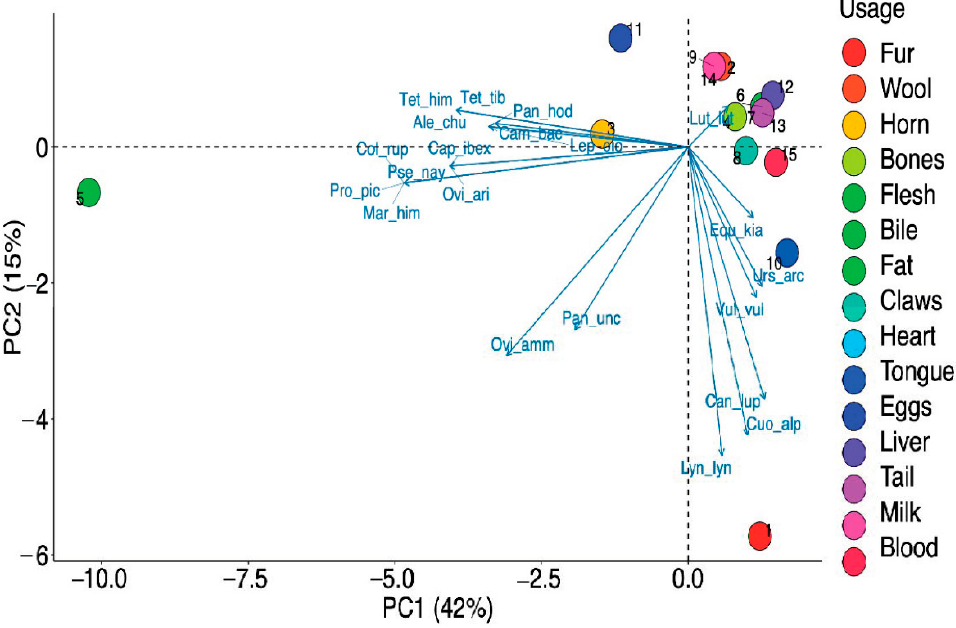
Figure 10. Principal Component Analyses (PCA) biplot of different part(s) usage.